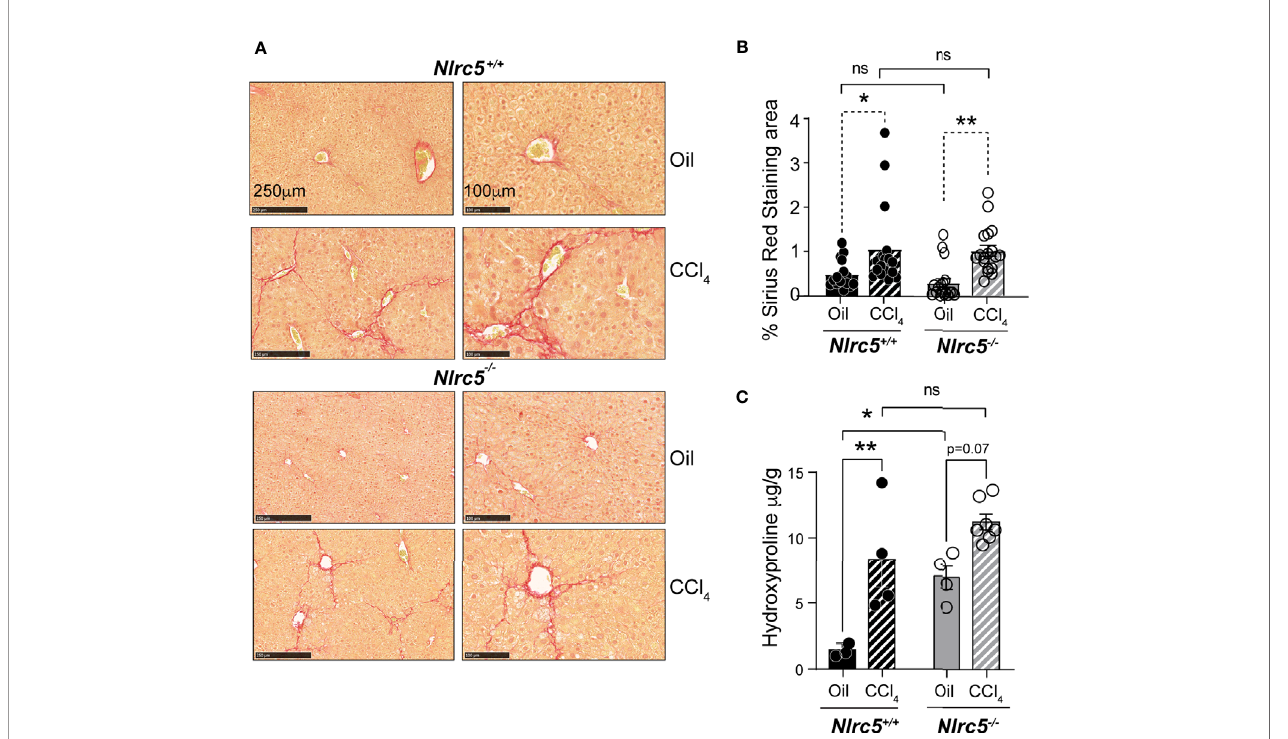
FIGURE 2 | CCl 4 -induced liver fi brosis in NLRC5-de fi cient mice is comparable to wildtype mice. (A) Sirius red-stained sections of oil- or CCl 4 - treated control and NLRC5-de fi cient livers at low (left) and high (right) magni fi cations. Data shown are representative of 4-5 mice per group from two independent experiments. (B) Quanti fi cation of Sirius red-stained area. Six randomly selected fi elds from liver pieces collected from different locations of each of the three mice per group were used for quanti fi cation. (C) Hydroxyproline content of livers from oil (n=3-4) or CCl 4 -treated (n=4-7) control and NLRC5-de fi cient mice. Data shown in (B, C) are mean ± SEM. Two-way ANOVA with Tukey ’ s post-hoc test: *p < 0.05, **p < 0.01, ns, not signi fi